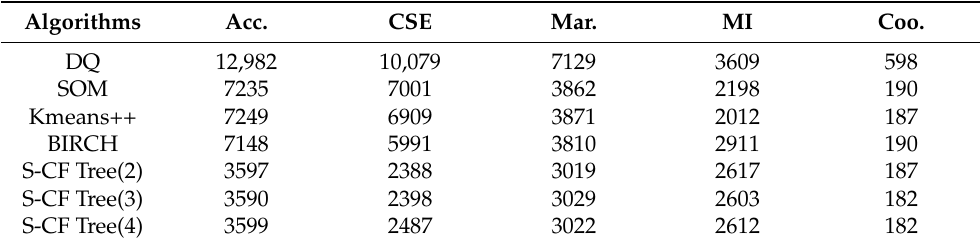
Table 6. Accuracy tests without feature selection